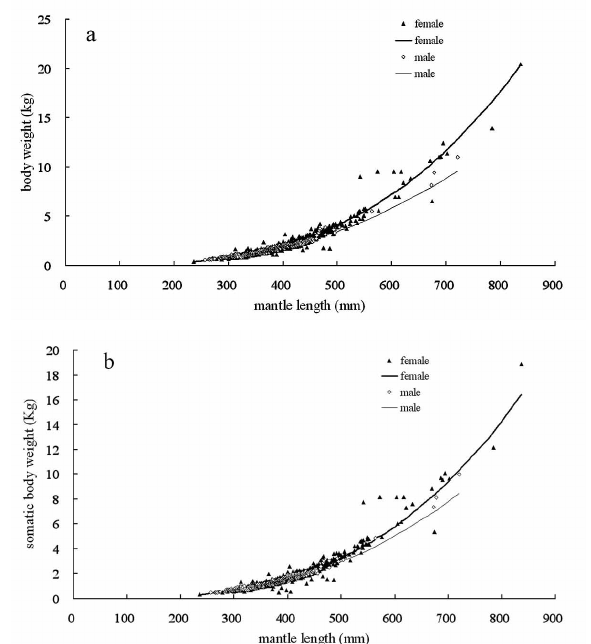
Fig . 3. – Mantle length (a) and body weight (b) compositions of female and male D. gigas during the three surveys off Chile between Fig . 4. – Relationships between body weight (a), somatic body April 2006 and May 2008. weight (b) versus mantle length for female and male D. gigas off